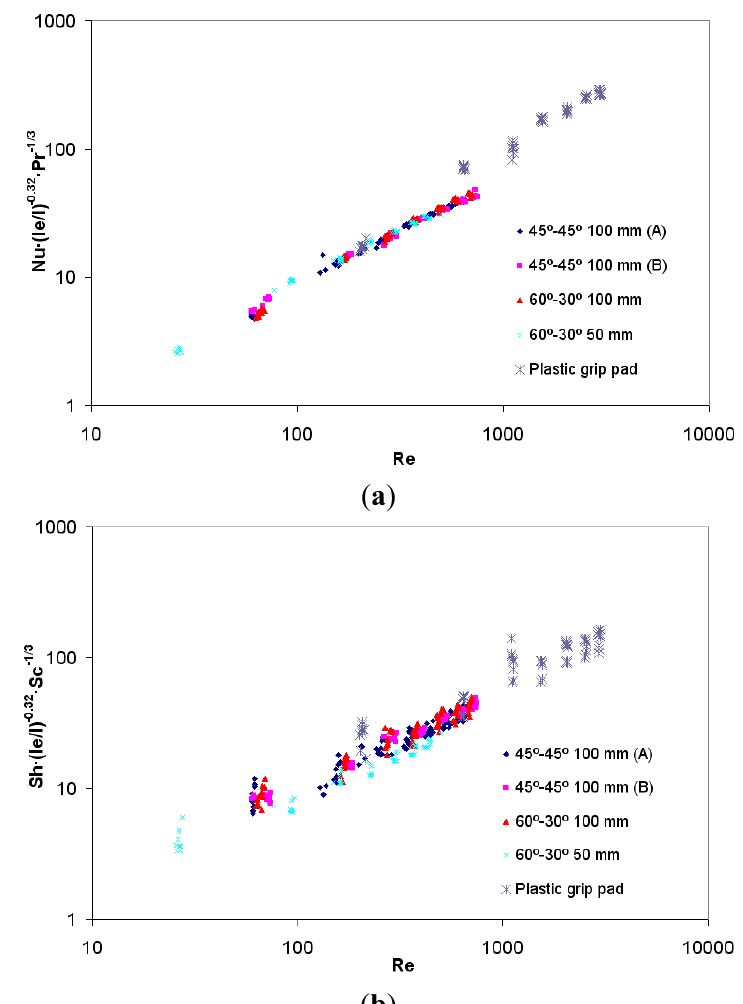
Figure 11. Calibrated non-dimensional correlations of ( a ) heat transfer coefficients and ( b ) mass transfer coefficients of all tested